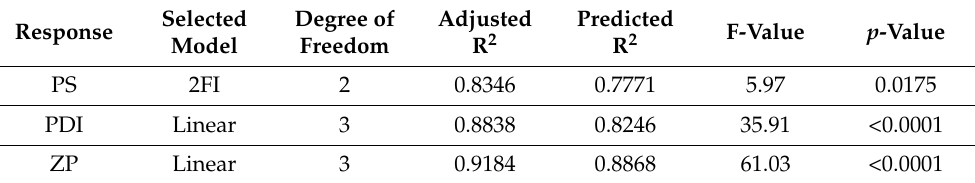
Table 2. ANOVA analysis of the measured responses for the selected